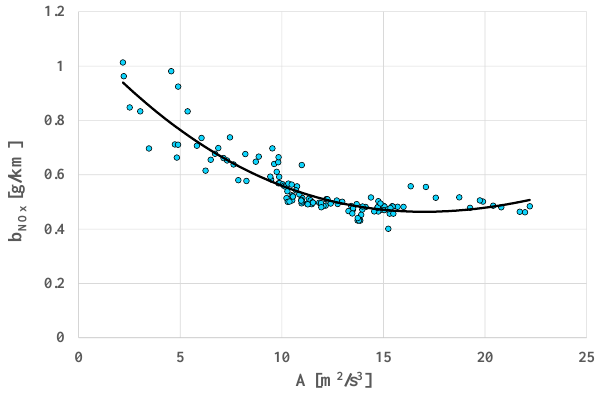
Fig. 20. Dependence of the average specific distance emission of nitrogen oxides on the average value of the absolute value of the product of vehicle velocity and acceleration in the Malta test